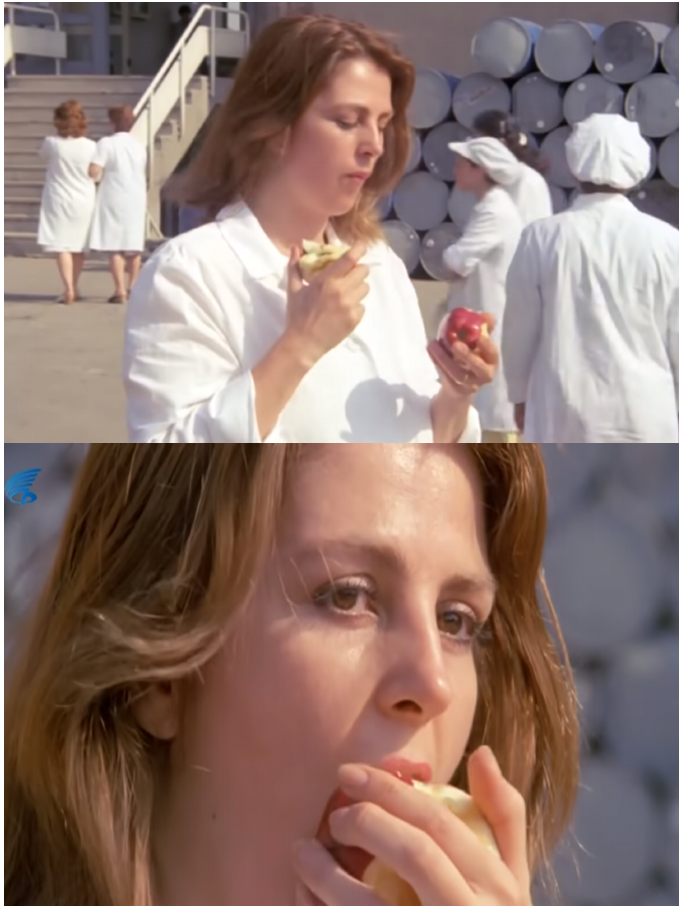
Figure 4-5: Aygül eats Cemal’s apple while he plays